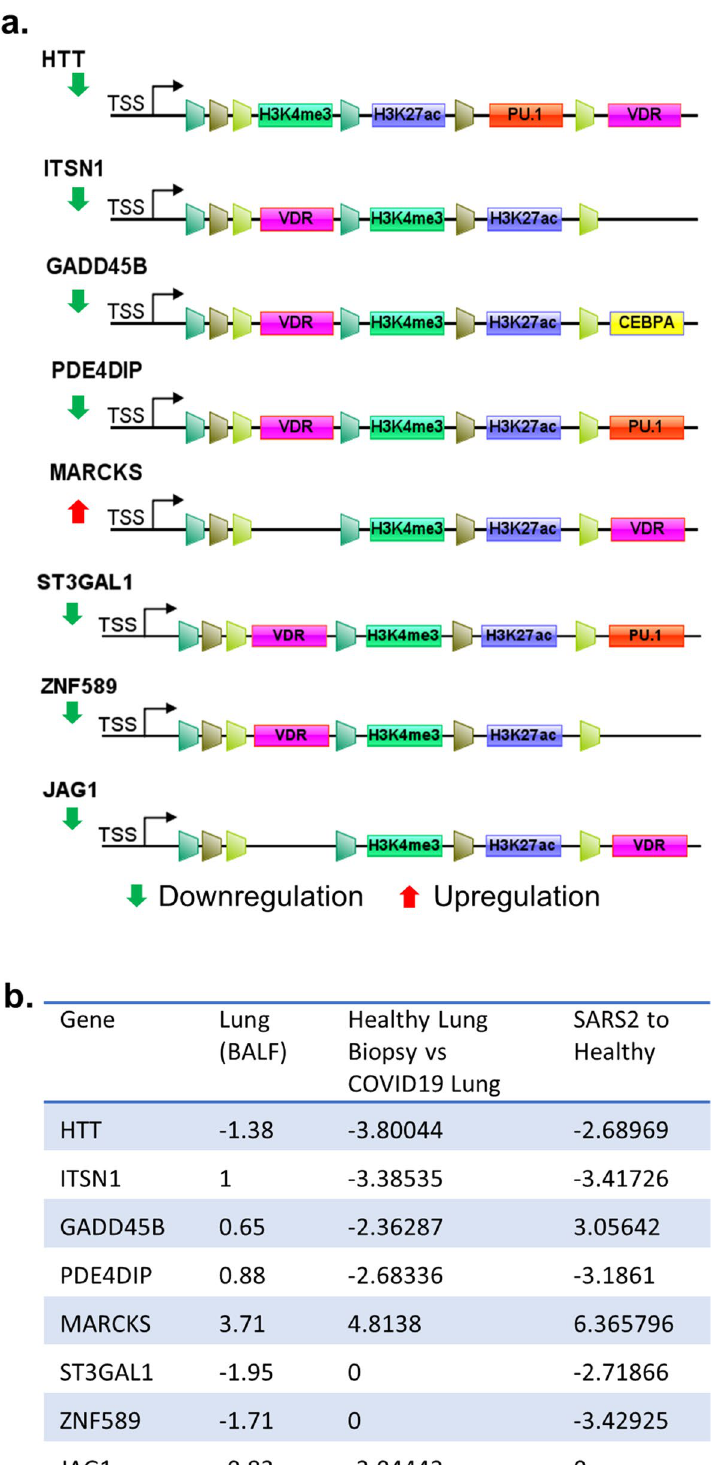
Figure 7. Analysis of postulated vitamin D target genes. ( a ) Status of VDR binding motifs, shared histone marks and TFs in TSS as well as enhancer regions. ( a ) Results when the analysis carried out for genes with VDR binding motifs. ( b ) Expression level of the genes in SARS-CoV-2 patient datasets are